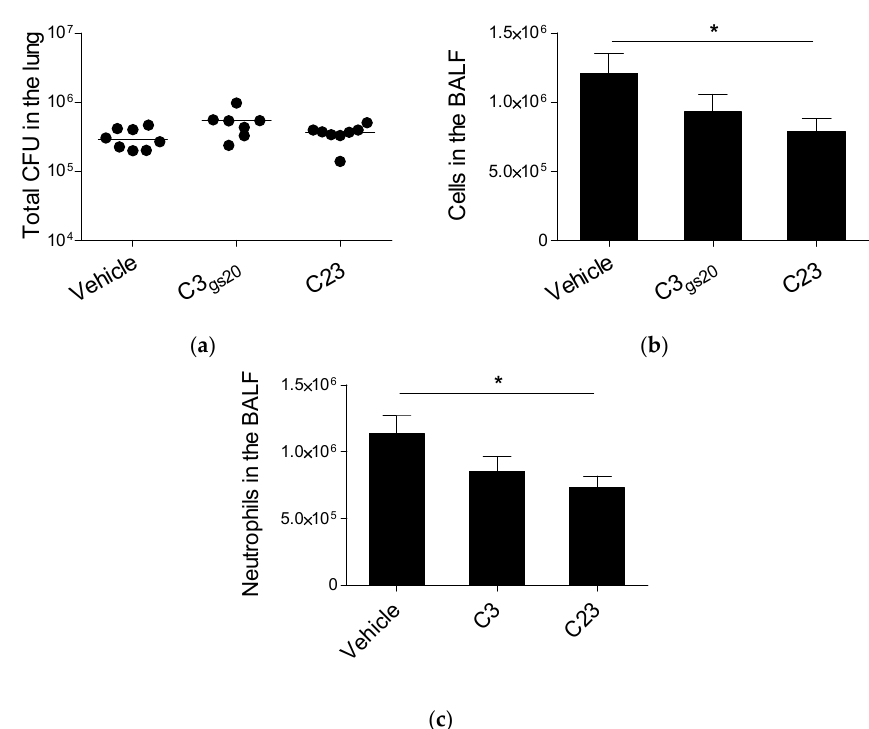
Figure 3. Modulation of the host response by synthesized HS competitors in a mouse model of acute P. aeruginosa lung infection. C57Bl/6NcrlBR mice were intratracheally injected with 5 × 10 6 CFUs of the highly virulent P. aeruginosa isolate AA2. Mice were subcutaneously treated with HS competitors (30 mg/kg) or their vehicle two hours before and two hours after the challenge and sacrificed 6 h post-infection. BALF and lung were recovered. ( a ) Total CFUs in the lungs were evaluated; ( b ) Total cell and ( c ) neutrophil recruitment was analyzed in BALF. The data are pooled from at least two independent experiments ( n = 7–8). CFUs in individual mice are represented as dots and horizontal lines represent median values. Cells are represented as mean ± SEM. Statistical significance is indicated: * p < 0.05. Table 2. Levels of cytokines and chemokines in murine lungs during acute P. aeruginosa lung